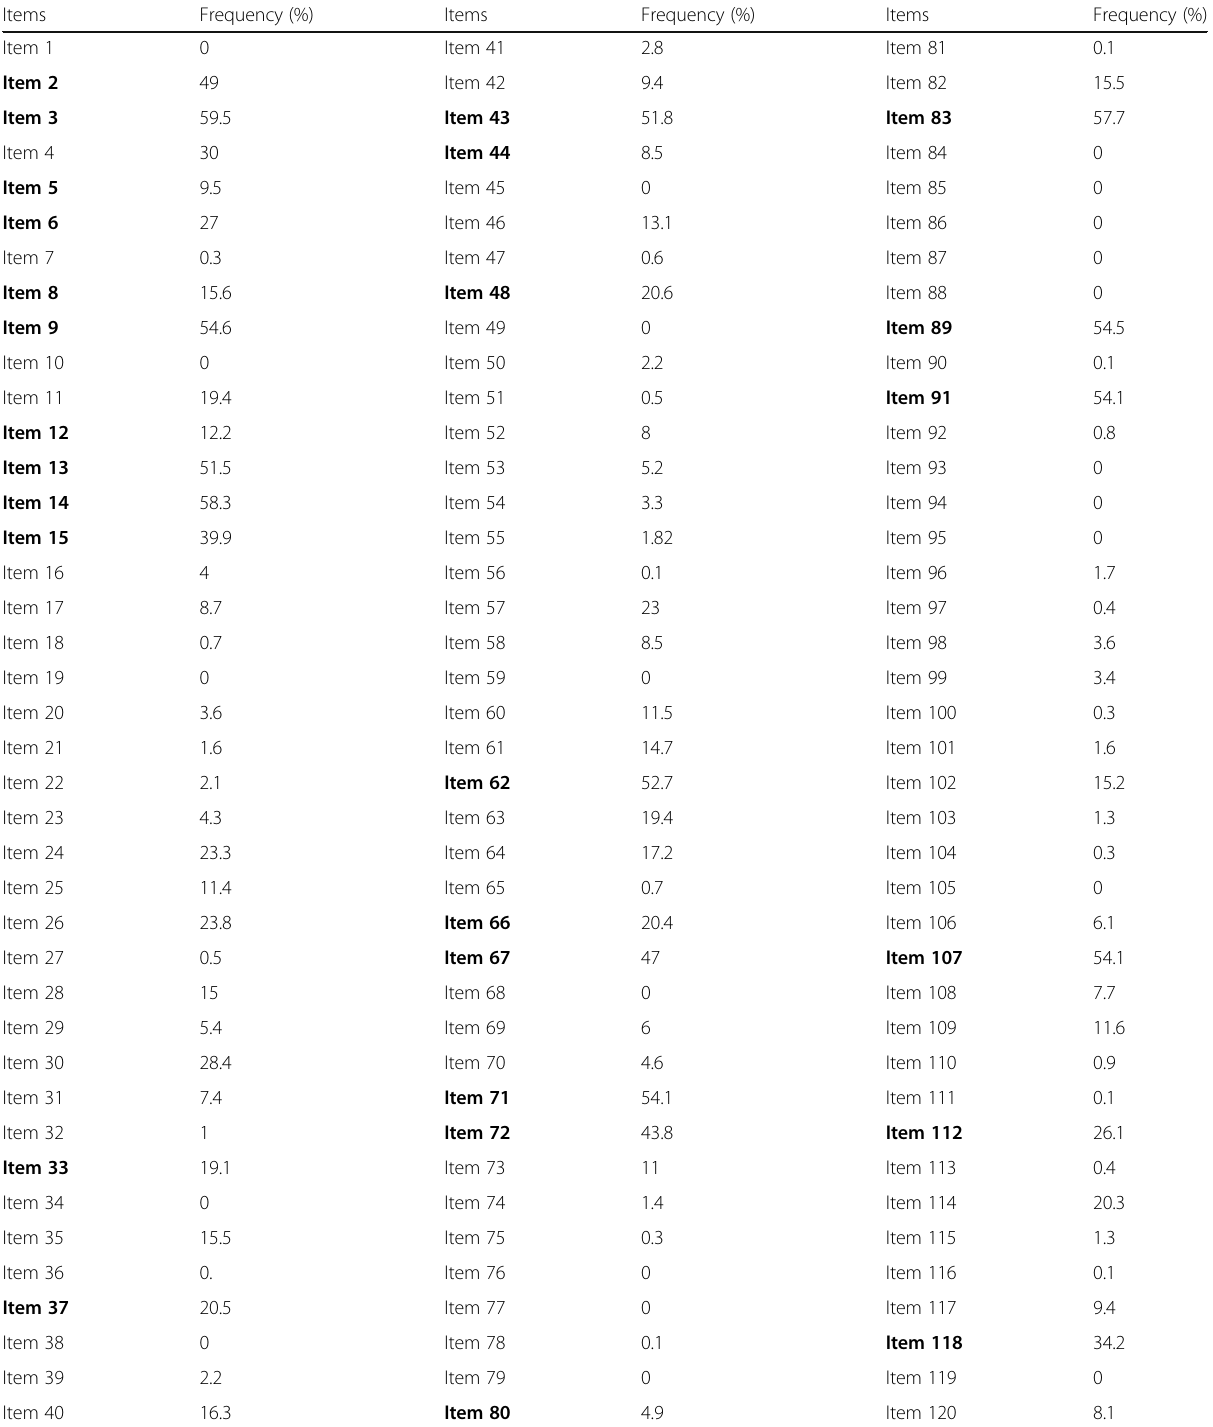
Table 2 Frequency of computerized adaptive test item